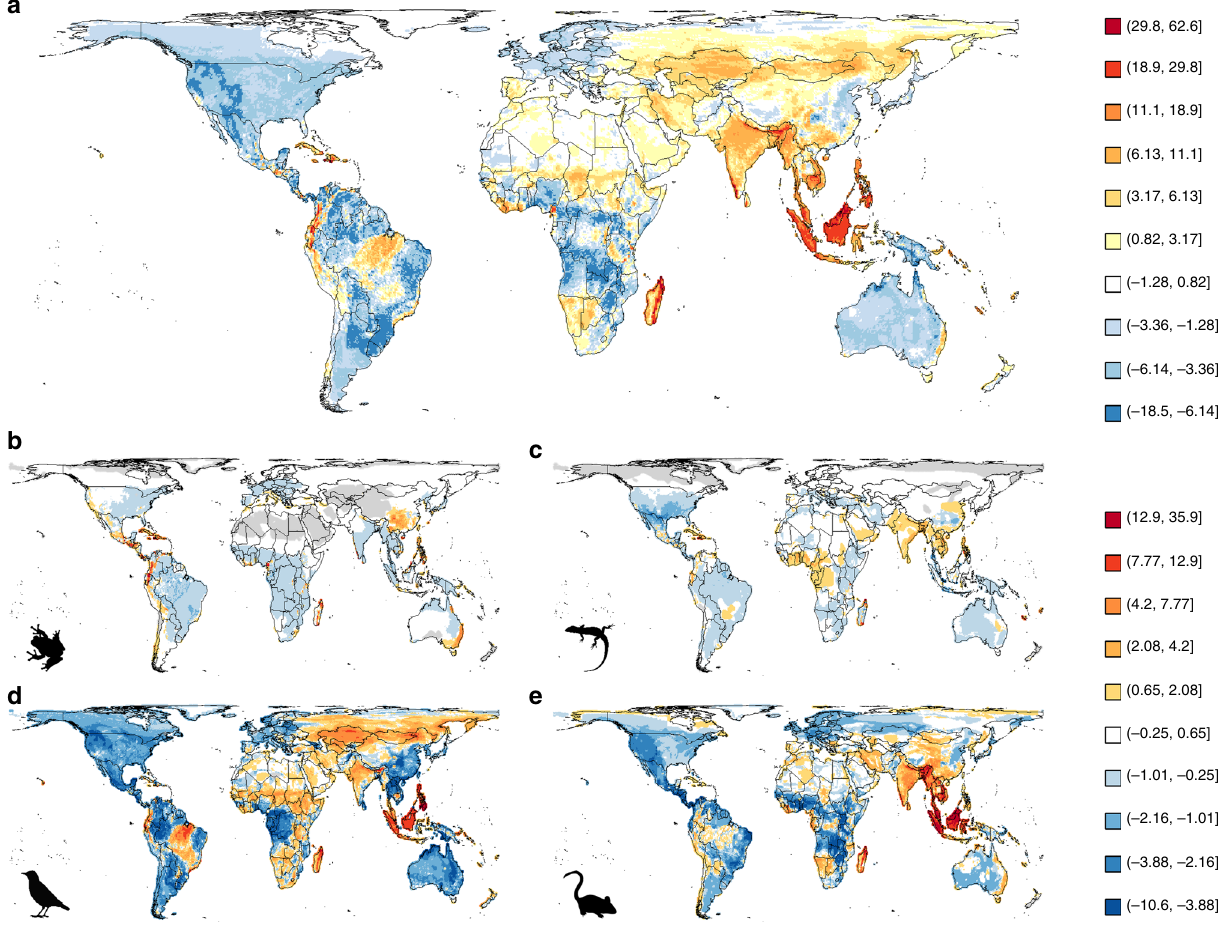
Fig. 1 Global variation in threatened species richness, having accounted for total species richness. The maps show the mean residuals from 10 global scale models of threatened species richness when explained by total species richness, for a terrestrial vertebrates, and four separate taxonomic groups: b amphibians, c reptiles, d birds and e mammals. The colour scale indicates model residuals in terms of the number of threatened species and uses Jenks natural breaks 81 to determine the break points. Note the scales differ between a , and b – e . Grey indicates areas where there are no species classi fi ed as threatened. Model performance was moderate (Table 1 and Supplementary Table 2). Source data are provided as a Source Data fi